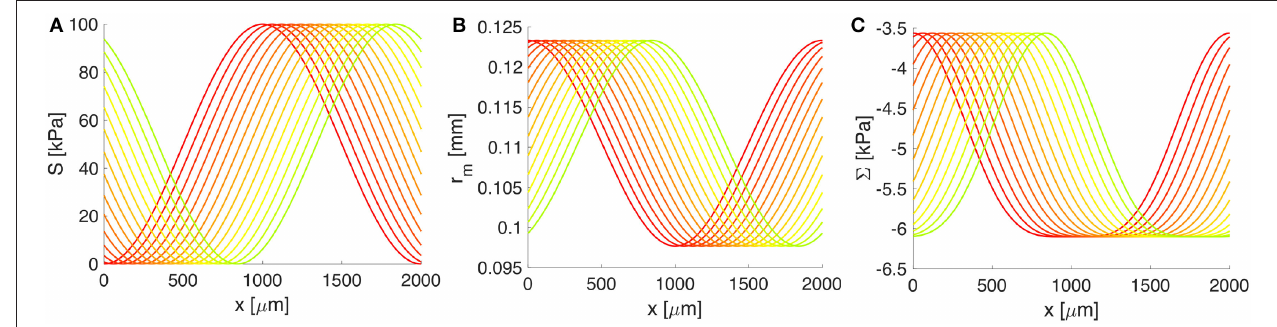
FIGURE 4 | The response of the artery wall to muscular oscillations over one wavelength. (A) The vasomotion wave, (B) the radial position of the BM, and (C) the constrictive stress acting on the BM. Both r m and 6 depend on S ( z , t ) and serve as input in the BM model. Progressive change from the red to the green curve shows increase in time; only 4 s from one vasomotion cycle of 10 s are